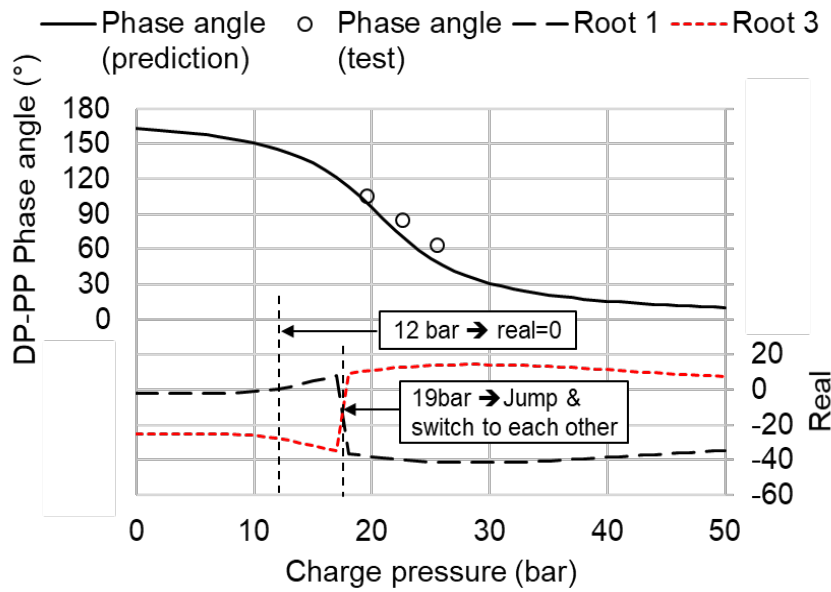
Figure 13. Predicted and measured DP–PP phase angles and real part values of roots 1 and 3 with charge pressures of 0–50 bar for case 1.